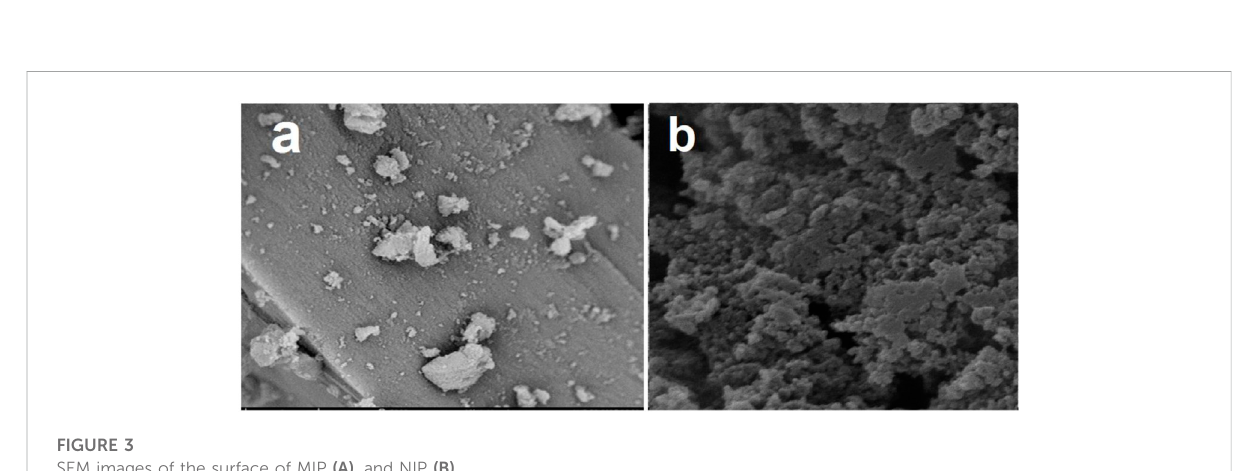
FIGURE 3 SEM images of the surface of MIP (A) , and NIP (B)